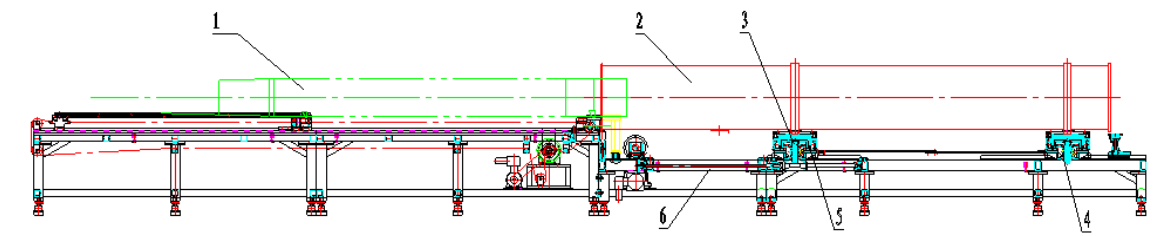
Figure 7 Loading equipment of tubular-structure